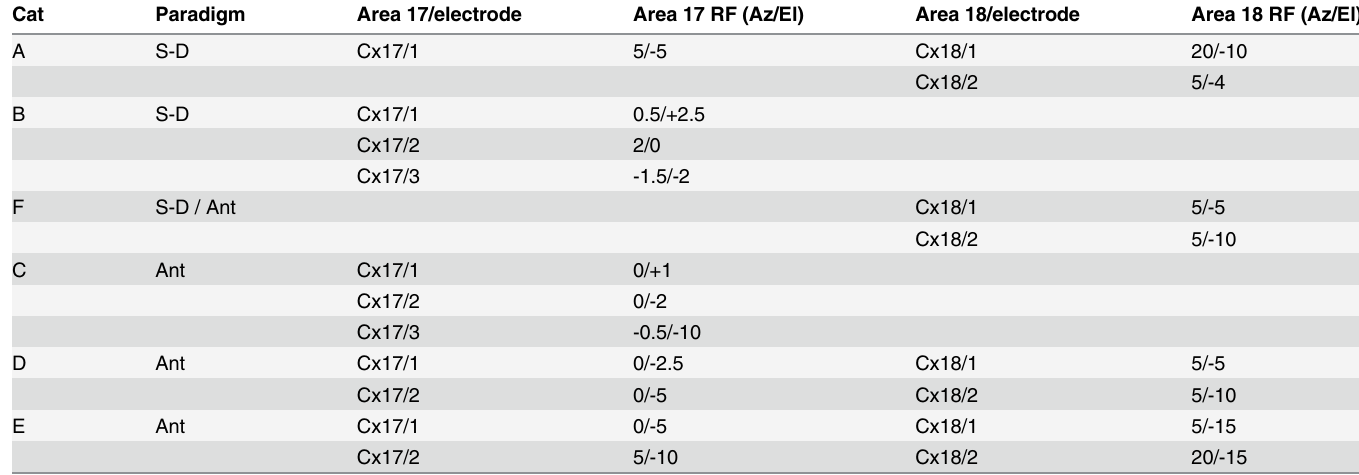
Table 1. Electrode location and corresponding retinotopic position in the experimental